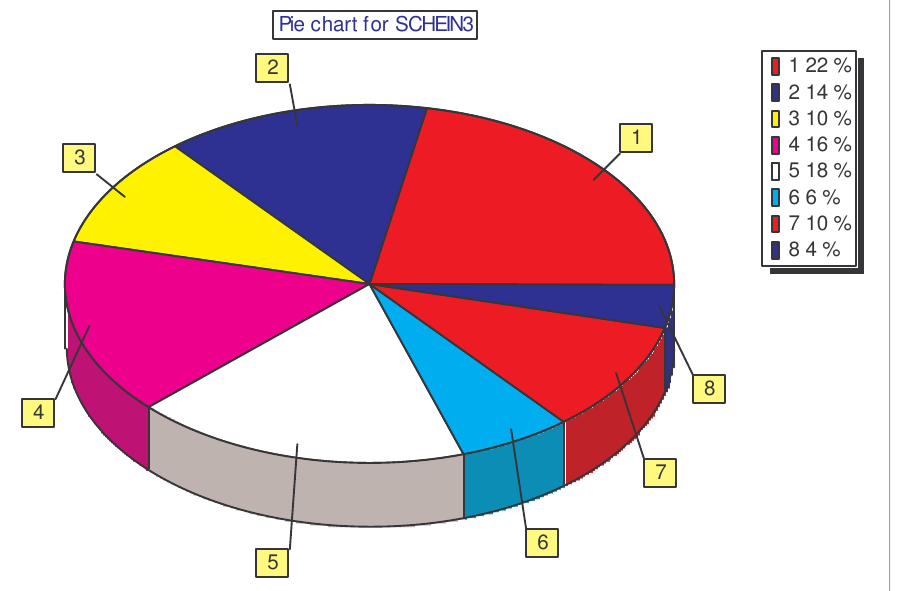
Figure 3: The tertiary career anchors of